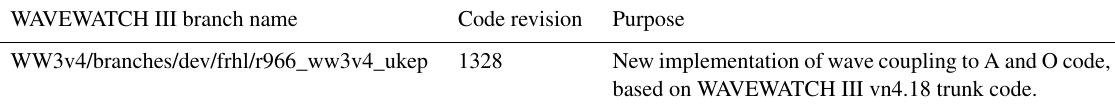
Table C6. Summary of the WAVEWATCH III code branch used in the UKC2 system, containing relevant adaptations from the baseline trunk code at version 4.18 (see links provided at http://polar.ncep.noaa.gov/waves/wavewatch/distribution, NOAA, 2017b). This code branch can be shared with registered users of WAVEWATCH III, with further details on applying for a license available at http://polar.ncep.noaa.gov/ waves/wavewatch/ (NOAA, 2017a).